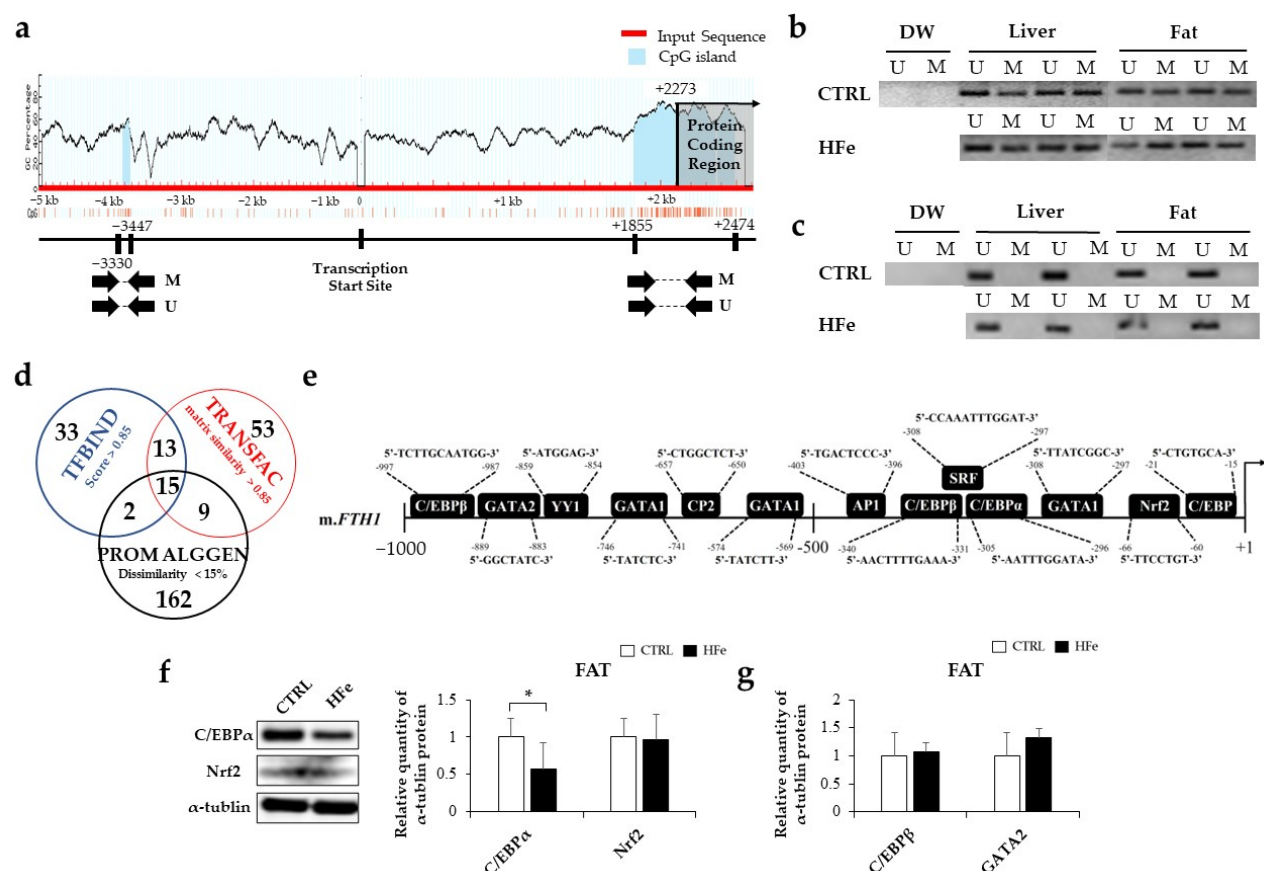
Figure 3. The change in FTH expression was not affected by DNA methylation in CGIs. ( a ) Schematic showing the tested regions for MSP at the FTH1 locus. Target regions were chosen using MethFinder (http://www.urogene.org/methprimer accessed on 19 April 2022) on regions upstream ( − 5 kb) and downstream from the FTH1 transcription start site. Agarose gel electrophoresis of MSP products are shown on ( b ) regions upstream ( − 5 kb) and ( c ) downstream (+3 kb) from CTRL- and HFe-fed offspring TFs in the FTH1 gene promoter region and were predicted using ( d ) PROMO ALGGEN, TRANSFAC and TFBIND software programs. ( e ) The binding sites of the TF detected in 3 databases. The spacing of the sites in the diagram reflects the typical spacing of the actual sequence. Solid arrows indicate transcription start sites. ( f ) Amount of protein levels of C/EBP α and Nrf2 and ( g ) mRNA levels of C/EBP β and GATA2 in fat are presented. Data are expressed as means ± SE; Student’s t test was used to test differences between means. * p < 0.05. M, product amplified with methylated-specific primer; U, product amplified with unmethylated-specific primer; DW, double distilled water control; AP1, activating protein-1; GATA1, GATA-binding protein 1; SRF, serum response factor; YY1, Yin Yang 1.